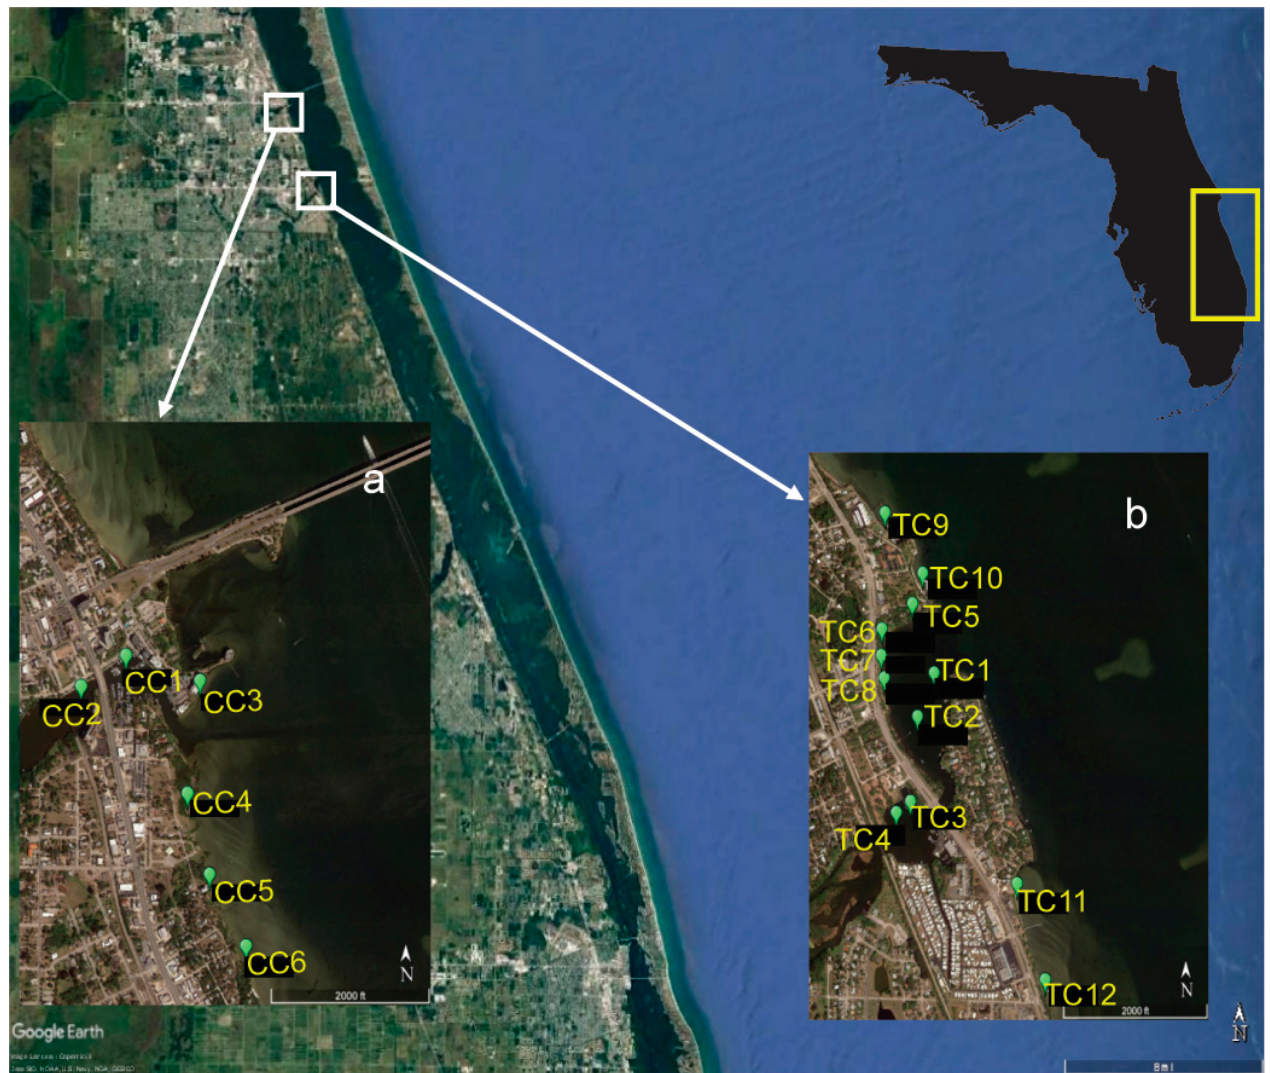
Figure 1. Florida and the region of interest in the Indian River Lagoon (box on inset), along with the stations in: ( a ) Crane Creek and the adjacent Indian River Lagoon, and ( b ) Turkey Creek and the adjacent Indian River Lagoon. CC1 and CC2 = stations in Crane Creek where muck was not dredged, CC3–CC6 = stations in the lagoon near Crane Creek where sediment that was not muck remained undisturbed, TC1–TC4 = stations in Turkey Creek where muck was dredged, TC5 and TC6 = stations in Turkey Creek where sediment that was not muck remained undisturbed, TC7 and TC8 = stations in Turkey Creek where sediment that was not muck was dredged, TC9–TC12 = stations in the lagoon